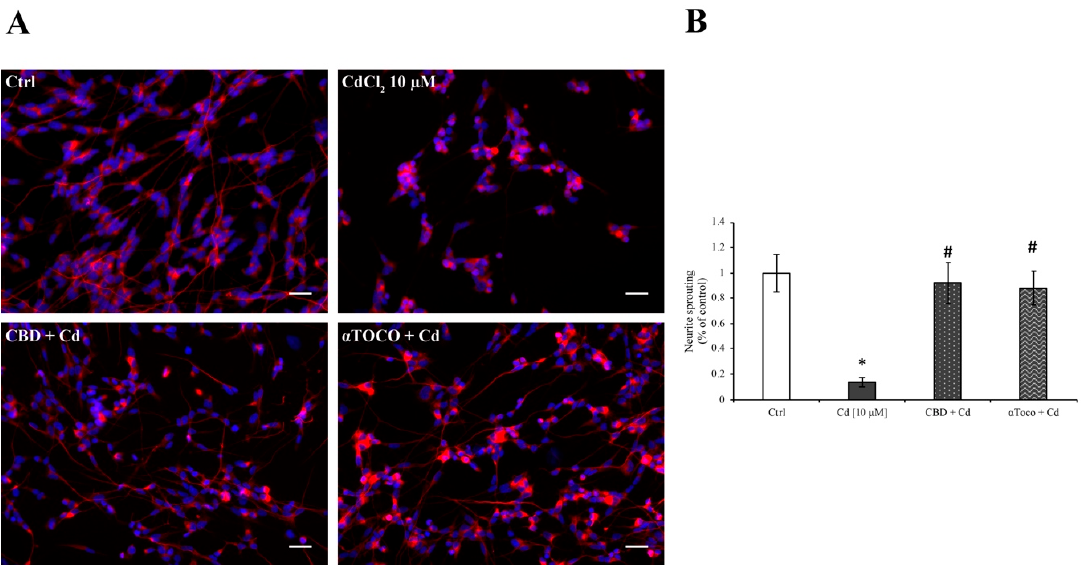
Figure 7. β 3 tubulin expression on SH-SY5Y . ( A ) the immunofluorescence staining revealed a very strong decrease of cytoplasmic elongations in CdCl 2 -treated cells. This deleterious event was prevented by the presence of CBD 1 µ M or α Toco 10 µ M. ( B ) highlights the number of neurite elongations, normalized on nuclei count. The results are expressed as mean ± S.E.M. and control, untreated cells are reported as 100%. The average number of cytoplasmic elongations were the following: Ctrl (197.4 ± 29.3), CdCl 2 10 µ M (27.2 ± 6.8), CBD + Cd (181.4 ± 31.7), α TOCO + Cd (173.9 ± 26.4). Each experiment point was performed in triplicate, from three di ff erent set of experiments. Total magnification: 200 × . Scale bar: 50 µ